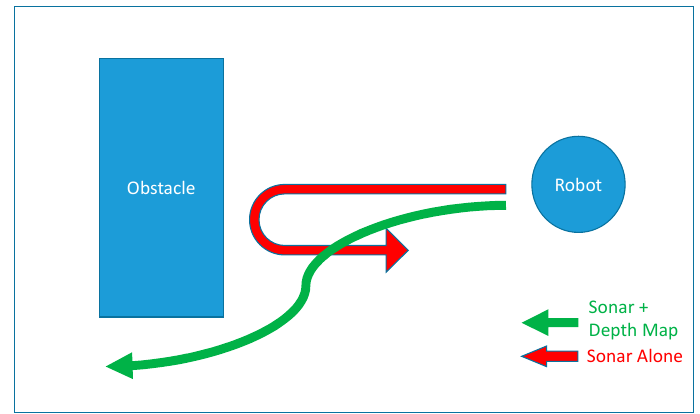
Figure 12. The path our robot takes when using sonars alone vs. combining sensors.